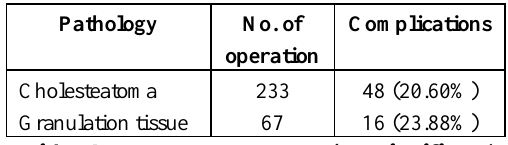
Table III. Comparison of types of